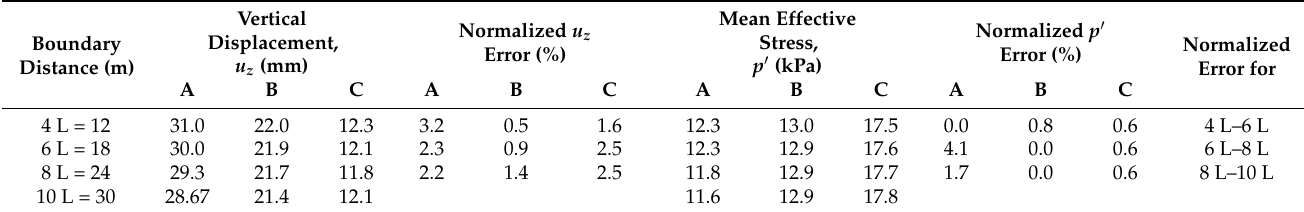
Table 6. Influence of the bottom boundary distance upon footing settlement.